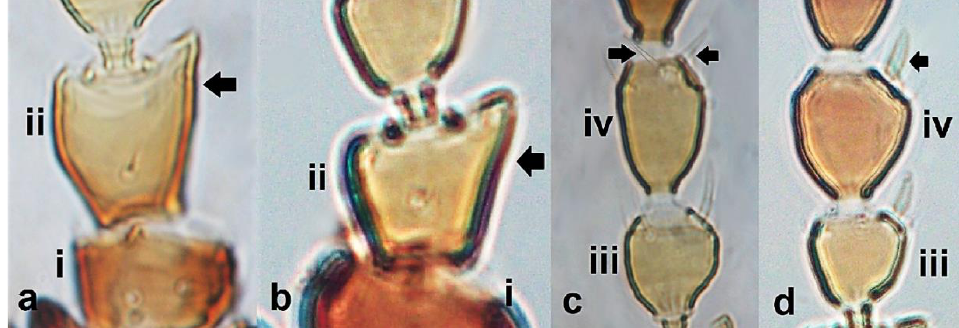
Figure 21. Antennal segment II showing outer edge ( a , b ): ( a ) nearly straight; ( b ) at an obtuse angle from the base of the segment; antennal segment IV ( c , d ): ( c ) with a forked sense cone; ( d ) with a simple sense cone. 21 Antennal segment II with the outer edge nearly straight (Figure 21a); antennal segment IV with forked sense cone (Figure 21c); antennal segment VII longer than VIII; males usually macropterous ................................................. Chirothrips meridionalis Bagnall Antennal segment II with the outer edge at an obtuse angle from the base of segment, creating a tip with bulge (Figure 21b); antennal segment IV with simple sense cone (Figure 21d); antennal segment VII shorter than VIII; males micropterous 22 Abdominal segment X bearing a pair of thorn-shaped setae (Figure 22a) ....................